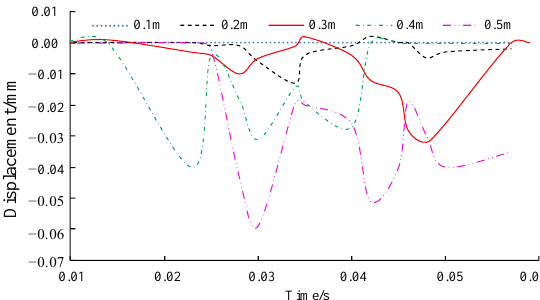
Figure 20. Displacement time history curve at the 5th layer.